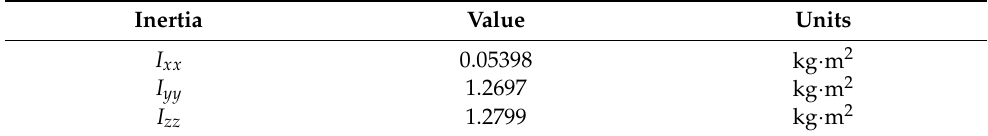
Combined term Fin lift